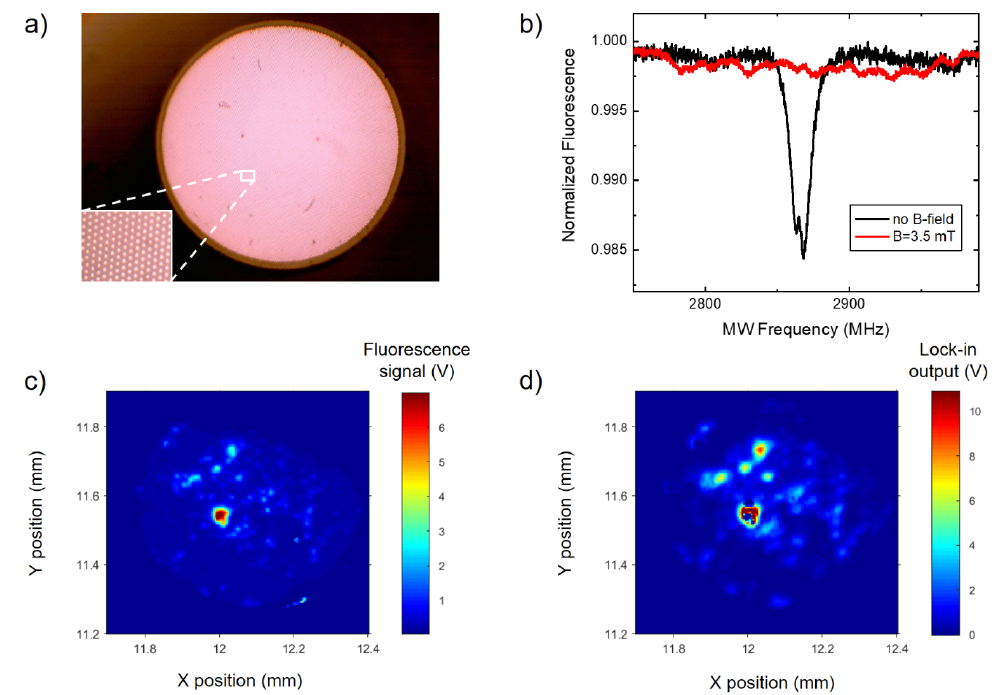
Figure 4. Remote sensing using IFB with a ND-coated distal facet located close to the MW antenna surface. ( a ) Optical microscope image of the fiber bundle. ( b ) ODMR spectrum measured through a single fiber of the IFB in zero and non-zero magnetic fields exhibiting single-crystal type resonances. ( c , d ) Fluorescence and the corresponding ODMR contrast maps acquired by scanning the proximal end of